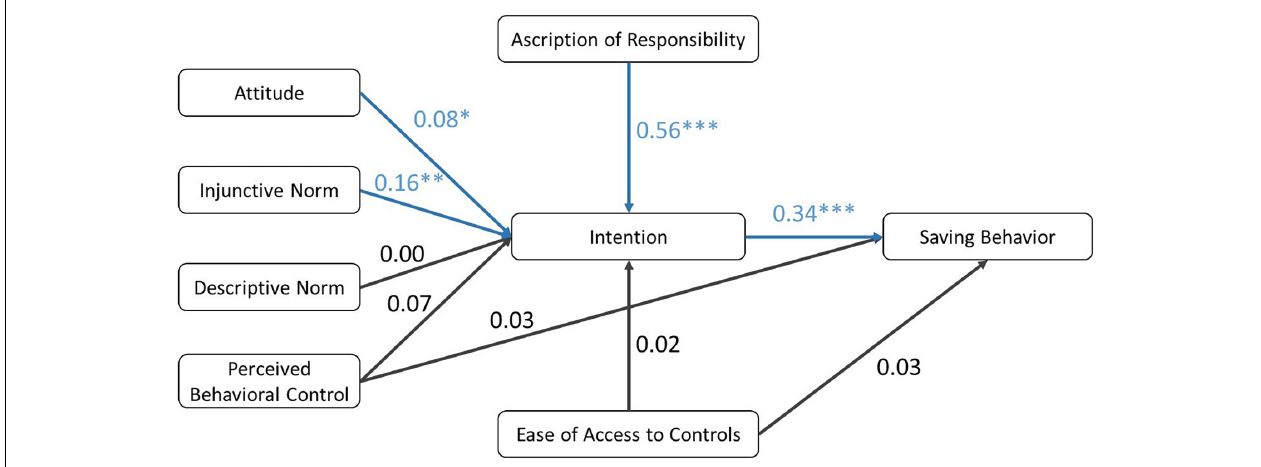
FIGURE 3 | Result of path modeling on the extended TPB model for single-person offices. * p < 0.05; ** p < 0.01; *** p < 0.001.